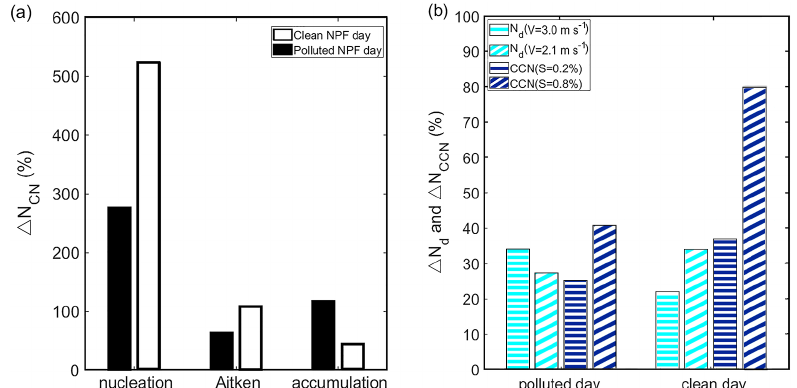
Figure 7. Comparison of the increments of (a) total particle number concentration ( N CN ) and (b) CCN number concentration ( N CCN ) and cloud droplet number concentration ( N d ) between the two different typical NPF